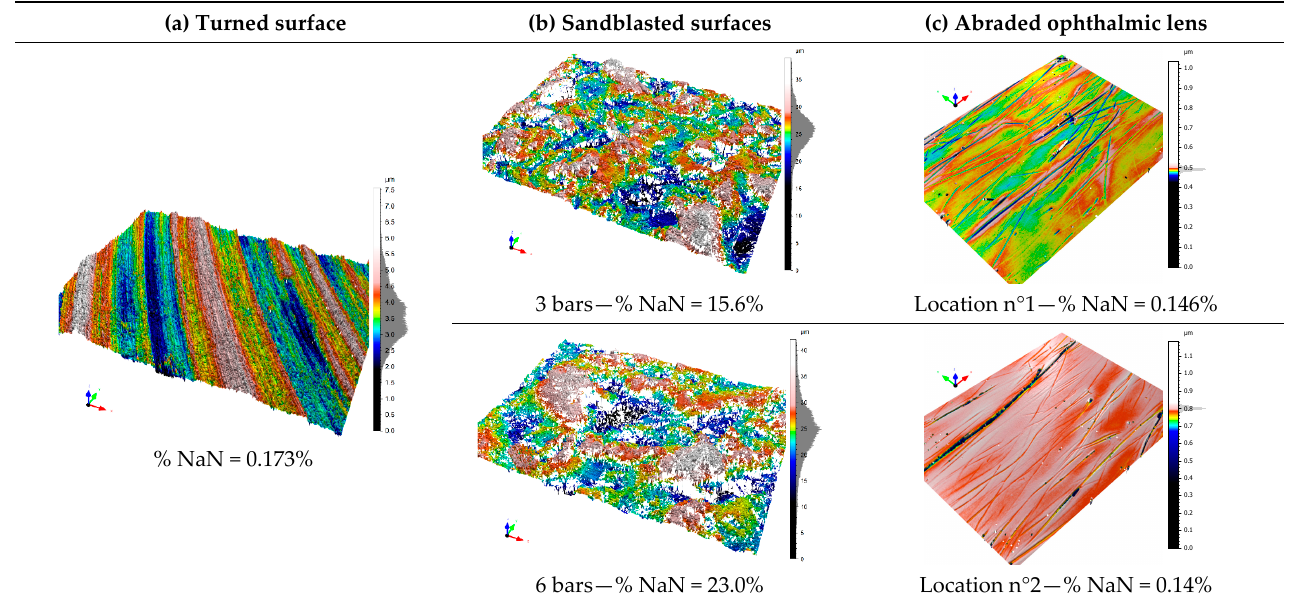
Figure 2. Renderings of measured topographies from surfaces turned ( a ), sandblasted under a pressure of 3 and 6 bars ( b ), and two zones of the abraded ophthalmic lens ( c ). One region is measured per process surface (turning and sandblasting) with White Light Interferometry (WLI—Bruker ContourGT™) with a 20× lens. For the ophthalmic lens, two regions were measured with Scanning White Light Interferometry (SWLI—Zygo NewView™ 7300) with a 50× lens (Figure 3). Each measurement instrument was placed on an anti-vibration table in an air-conditioned room at 20 °C. One hundred measure- ments, always at the same position, were performed for each set of maps M , which corre- sponds to approximately 20 min per measured region at one location. The sizes of the measured regions are 315 × 236 µm² (640 × 480 pixels) for the Bruker Contour GT™ and 140 × 105 µm² (640 × 480 pixels) for the Zygo NewView™ 7300.